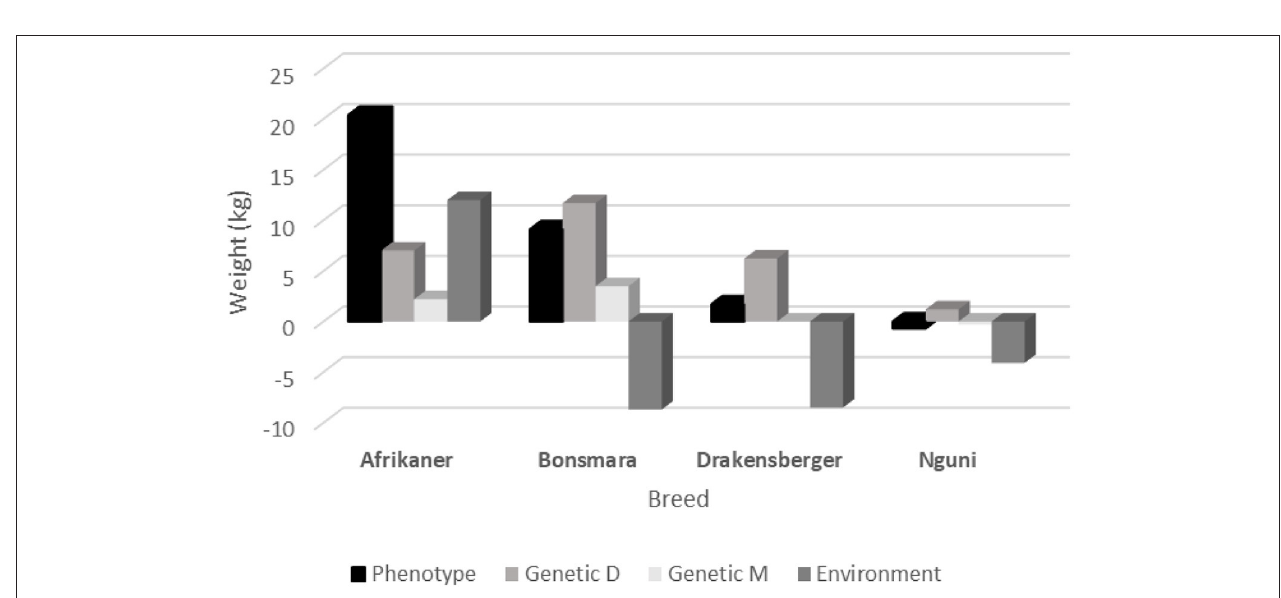
FIGURE 3 | A comparison of the different trends in weaning weight (phenotypic, direct, maternal, and environmental) of the four